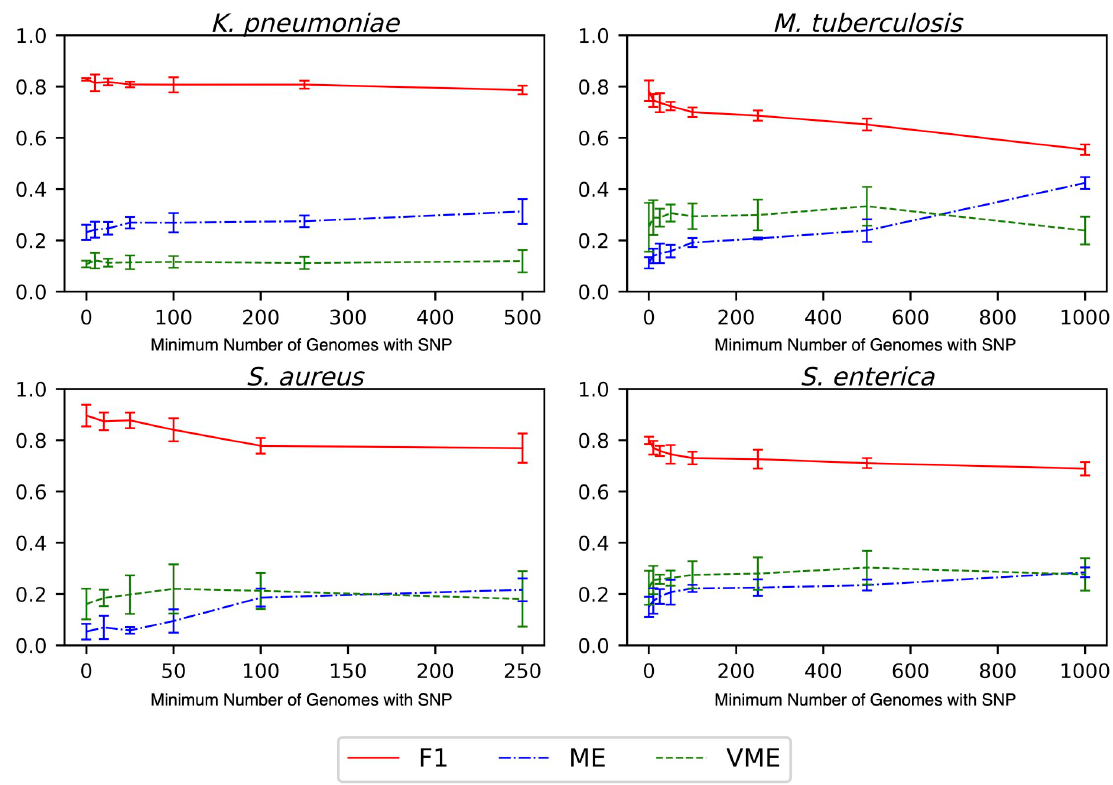
Fig 7. The effect of removing strain-specific SNPs prior to building models. SNP-containing alignment columns with less than 10, 25, 50 etc. nucleotides of the same type were successively removed and a model was generated. The X-axis depicts the SNP conservation and the Y-axis depicts the F1 score. The F1 score (red line), ME rate (blue line), and VME rate (green line) are shown. Error bars depict the 95% confidence interval. ME, or major error, is defined as a susceptible genome that is misclassified as being resistant. VME, or very major error, is defined as a resistant genome that is misclassified as being